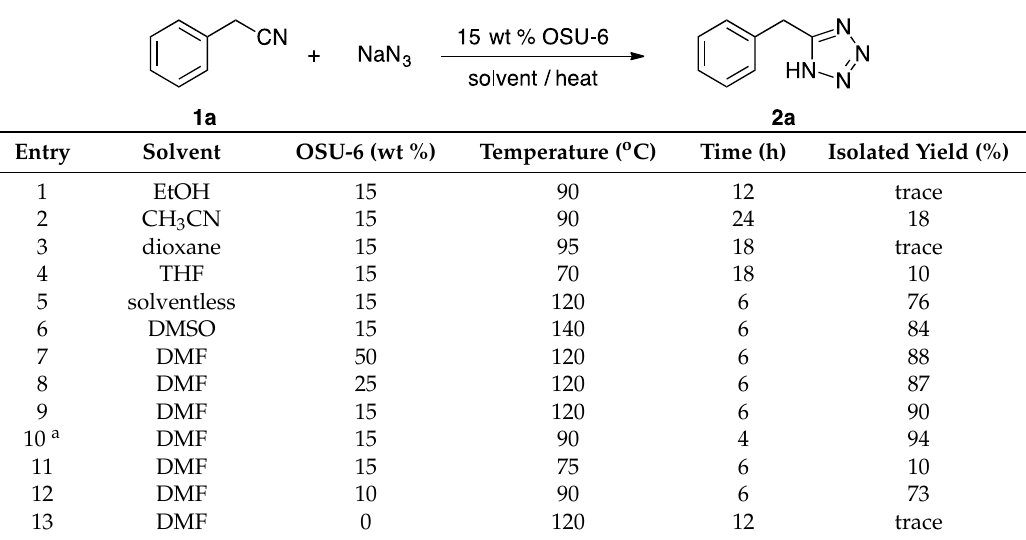
Table 1. Reaction optimization.